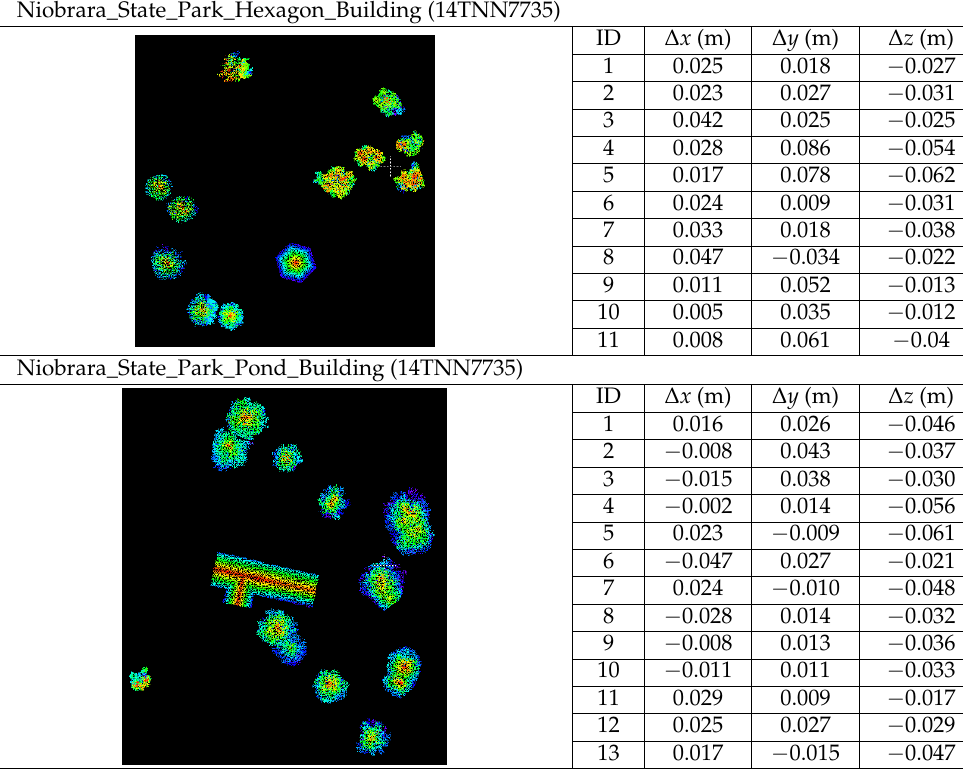
Table 3. Final accuracy of airborne point cloud using the amorphous object method.